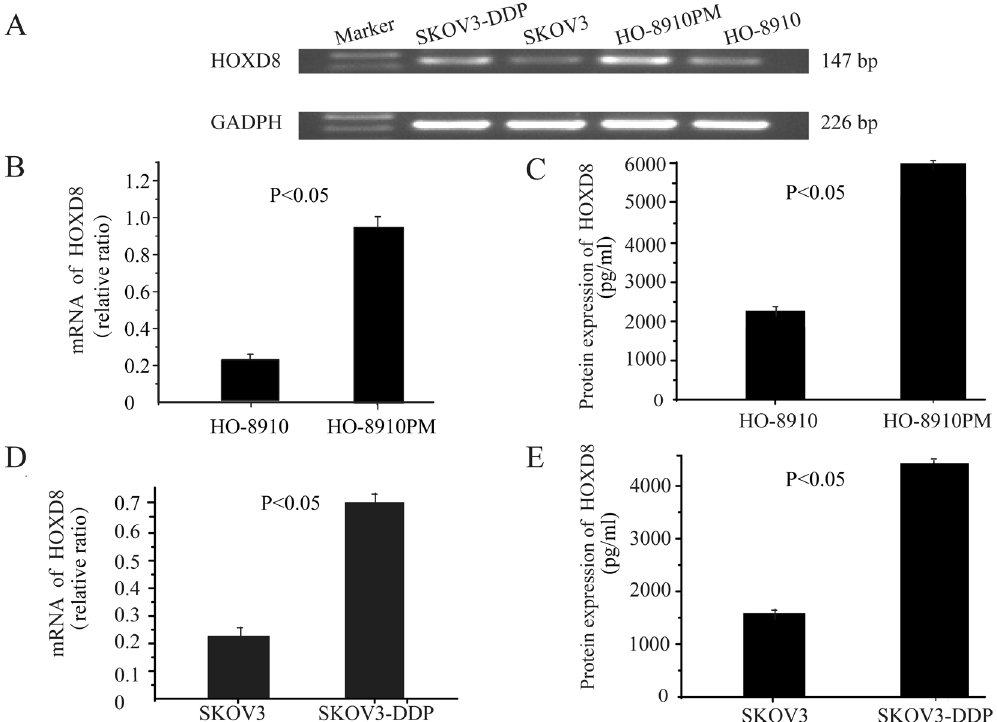
Figure 5. Different expression of HOXD8 in different cell lines ( A ). The mRNA expression levels of HOXD8 in HO-8910PM cell, HO-8910 cell (0.98 ± 0.08 vs . 0.21 ± 0.01, p = 0.04) ( B ). ELISA showed that the protein expression of HOXD8 in the HO-8910 cell lines was significantly different from that in HO-8910PM cell lines, (5965.34 ± 1.04 pg/ml vs . 1930.50 ± 2.50 pg/ml, p < 0.05) ( C ). The mRNA expression levels of SKOV3- DDP were higher in SKOV3 cells (0.71 ± 0.03 vs . 0.24 ± 0.04, p < 0.05) (D ). ELISA showed that the protein expression of HOXD8 in the SKOV3 cell line was 1584.40 ± 2.08 pg/ml, but in the SKOV3-DDP cell line, it was 4423.30 ± 1.52 pg/ml. The difference was significant ( p < 0.05) ( E